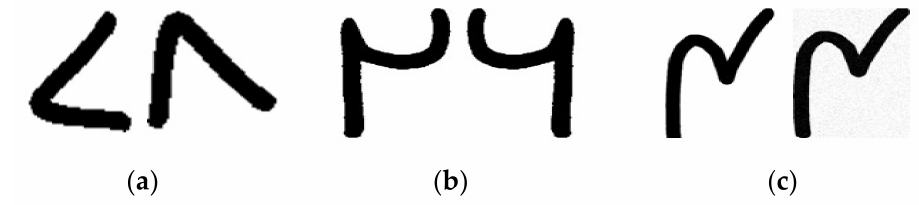
Figure 9. Sample of ( a ) rotated image, ( b ) flipped image, and ( c ) noisy